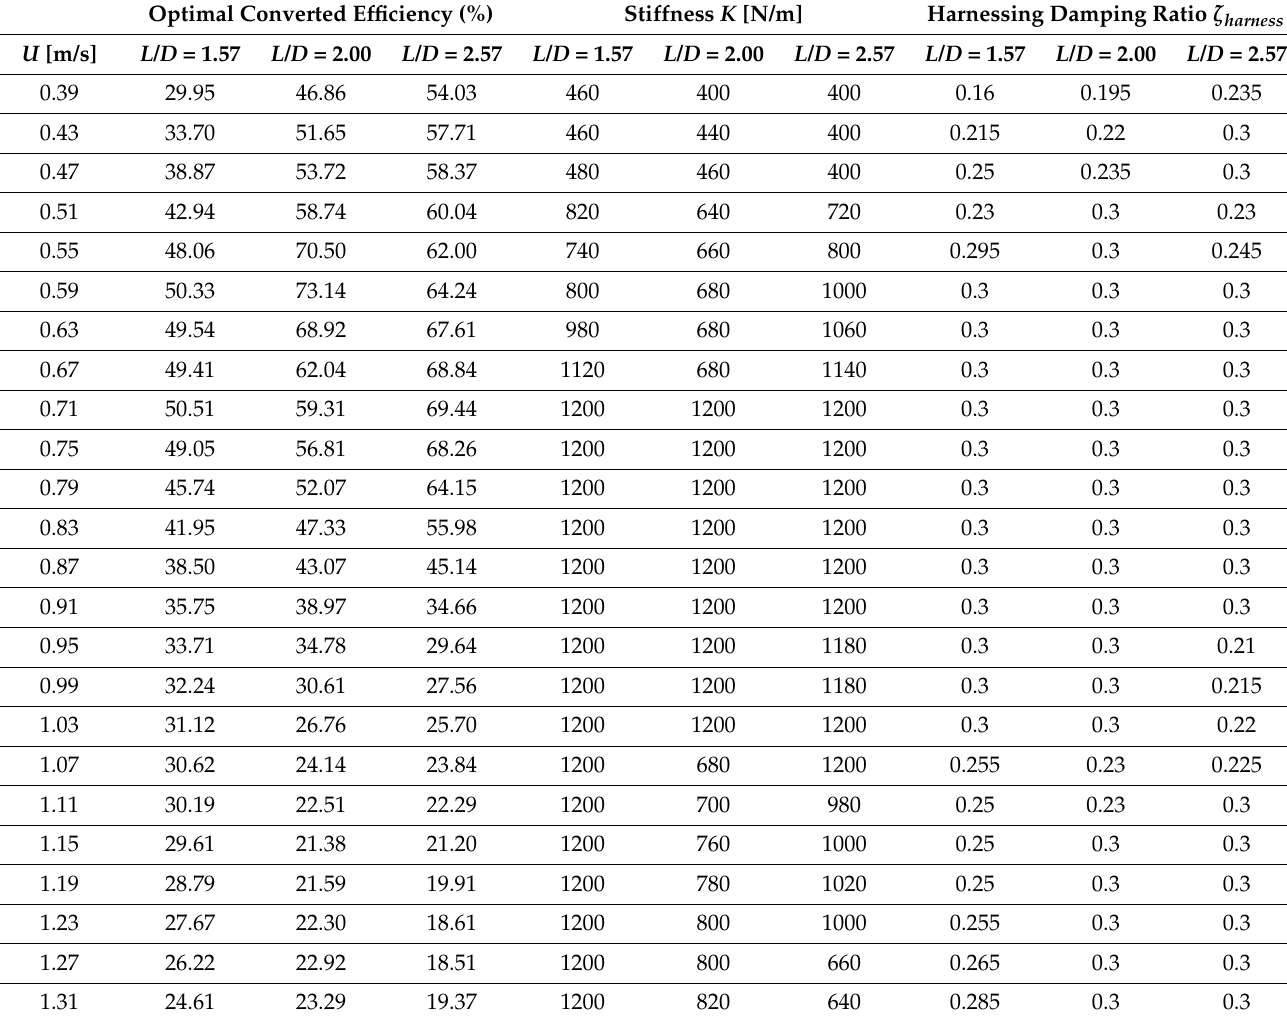
Table A2. Parameters for optimal converted efficiency for two tandem cylinders with spacing: L / D = 1.57, 2.00 and